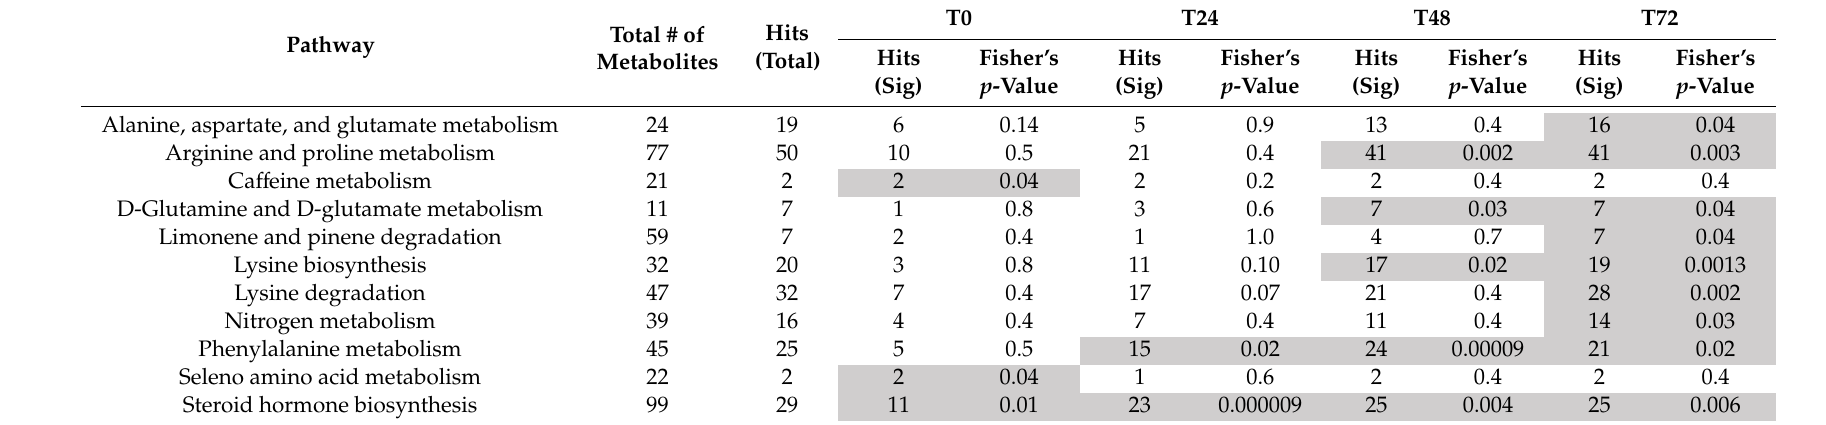
Note: Results with a Fisher’s p -value < 0.05 are